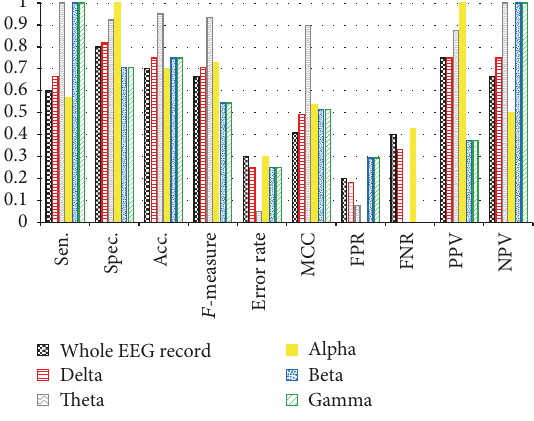
Figure 10: LZC performance.